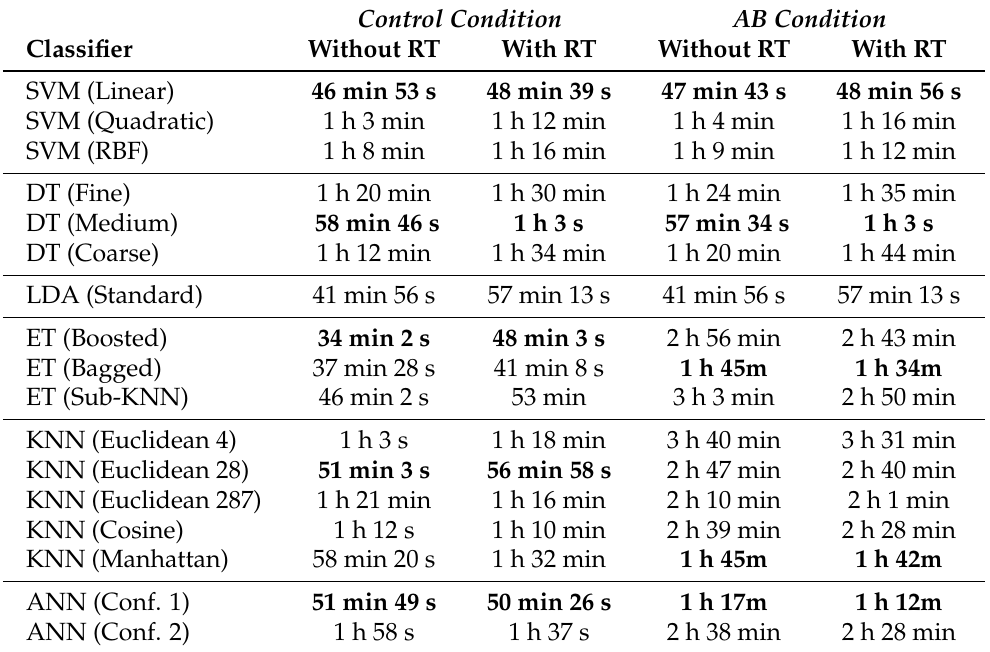
Table 5. Training time for each classification